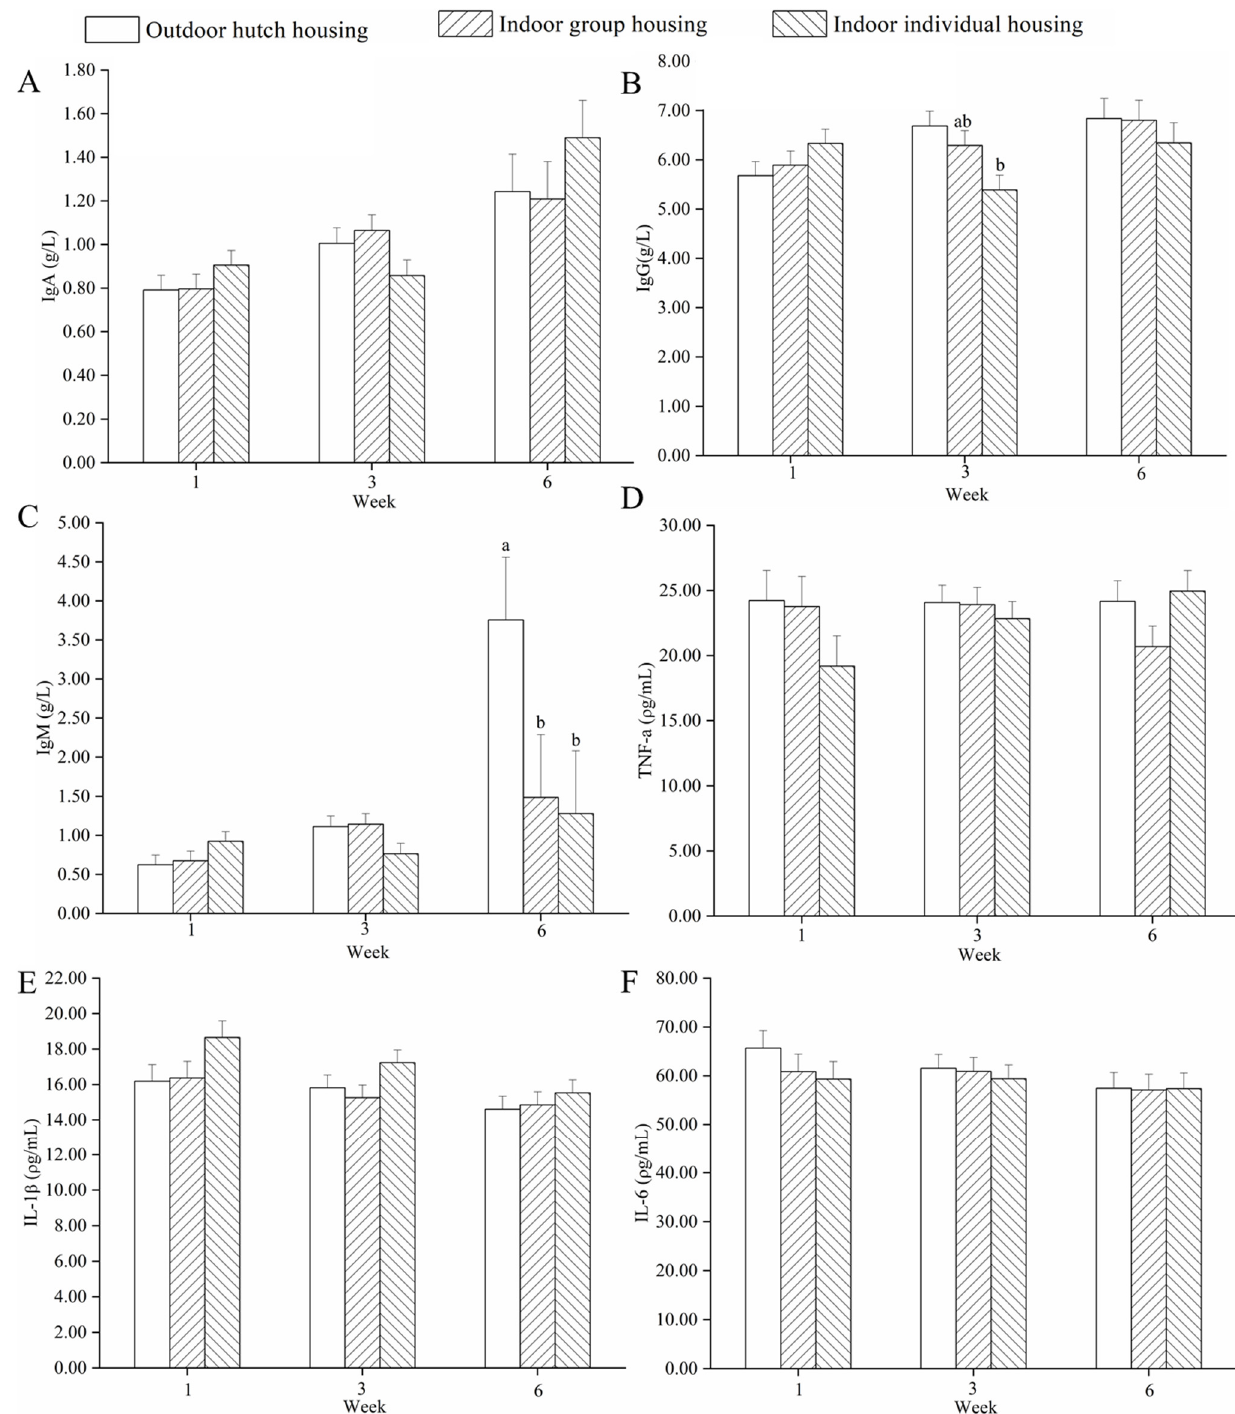
Figure 4. Concentrations of biochemical parameters of the calves in the different housing systems. with different letters within the same week of calves were significantly different ( p < 0.05) between the three rearing systems.